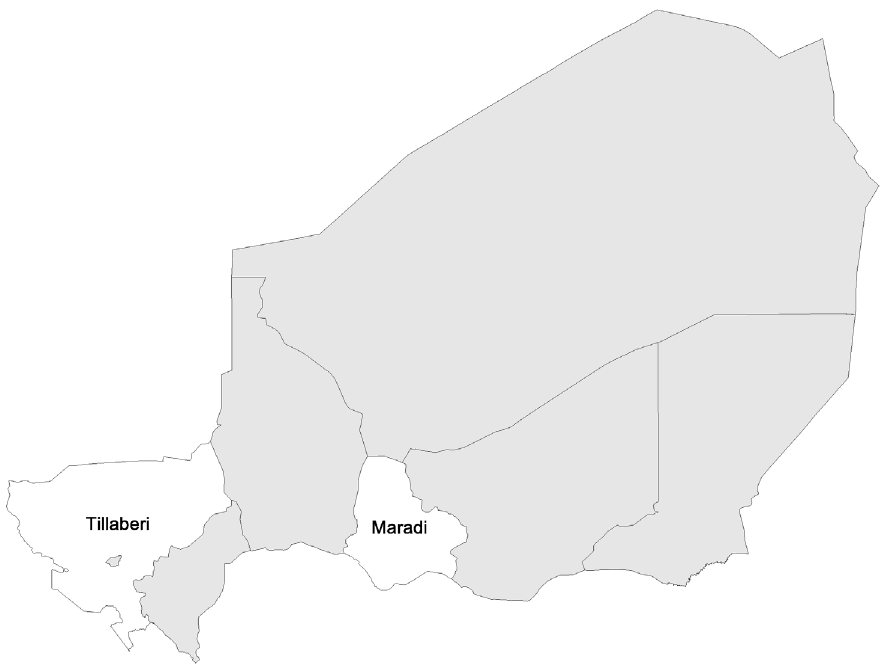
Figure 3. Map of Niger fieldsites.